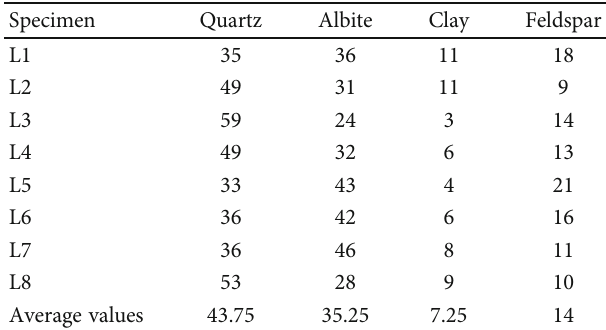
Table 2: Primary mineral contents in the oil sand (%).